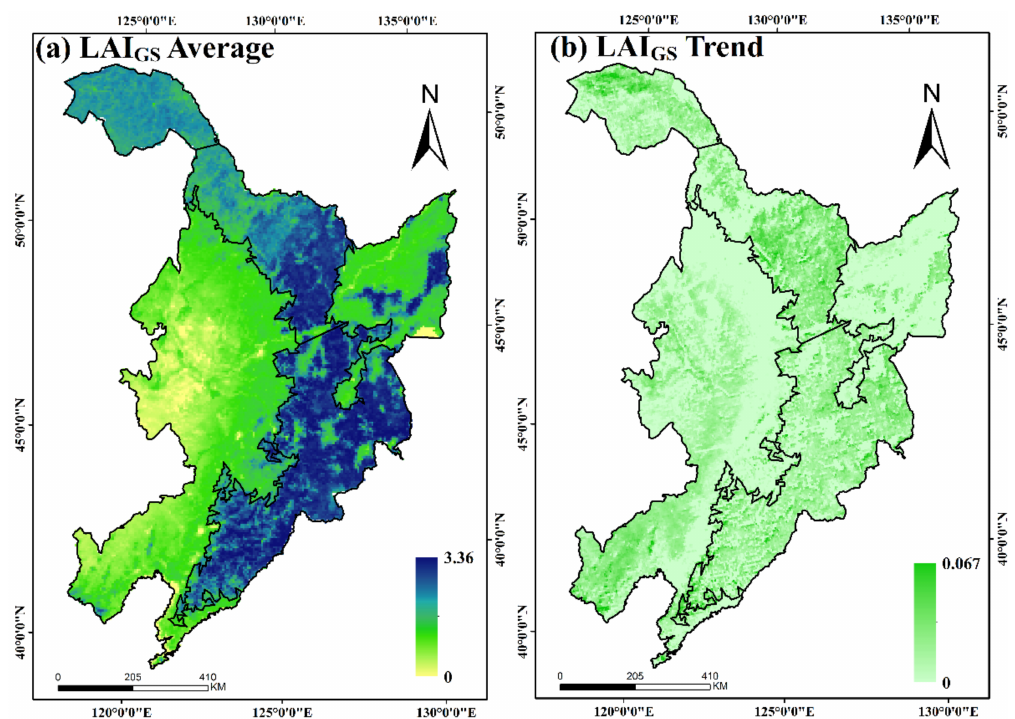
Figure 6. Spatial distribution of ( a ) multi-year average mean value of LAI within the growing season (LAI GS ) and ( b ) trend in LAI GS across the NEC from 1982 to 2015.